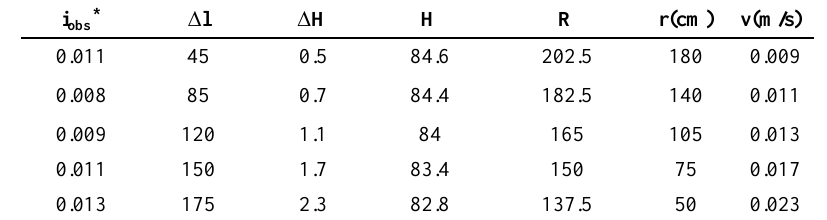
Table 6. i values measured by the Method III in the depth of 85 cm and level of 20 obs